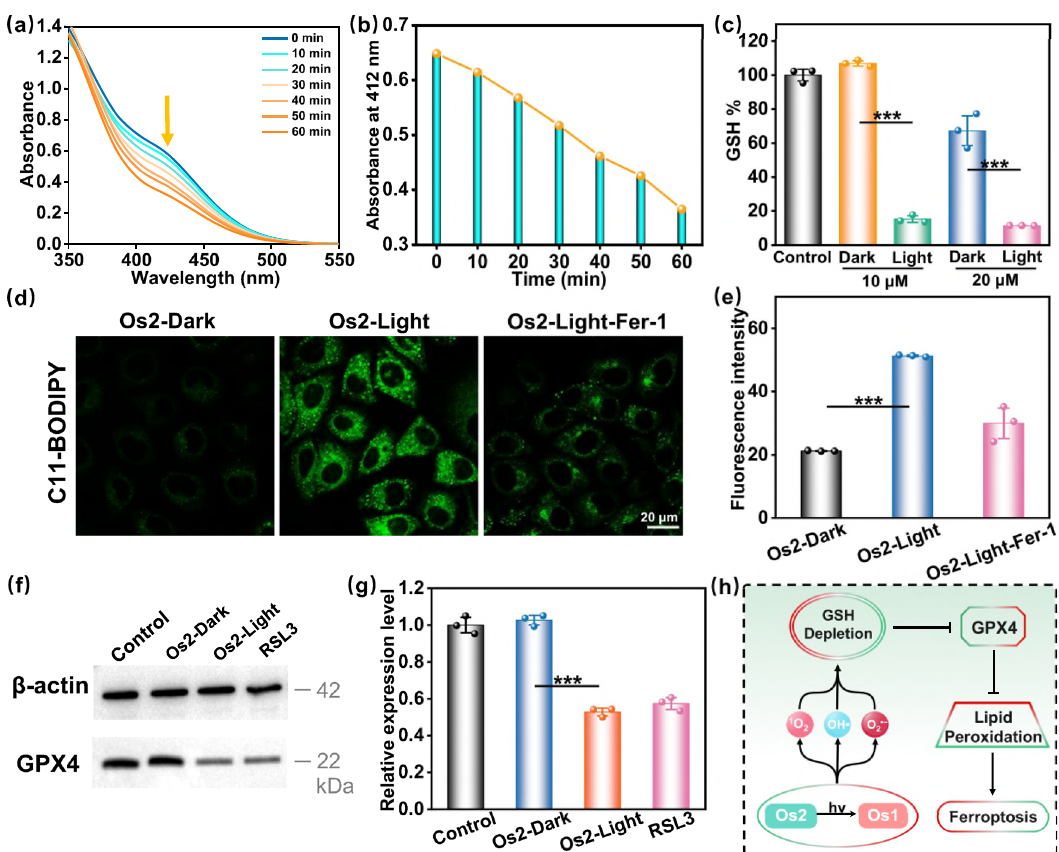
Fig. 5 Ferroptosis induction by Os2 under light irradiation. a Irradiation time-dependent GSH (200 μ M) depletion by Os2 (20 μ M) upon blue light irradiation at 298K and b the absorption at 412 nm was decreased by increasing the irradiation time. c The GSH levels in cells after different treatments. All the experiments were performed as duplicates of triplicates ( n = 3 biologically independent samples, p values ( p ): 10 μ M-0.000025, 20 μ M-0.00065). d The fl uorescence images of lipid peroxides in the treated cells detected by C11-BODIPY probe (30 μ M, 310 K, 0.5 h). C11-BODIPY: λ ex = 488 nm, = 570 ± 50 nm. e The average fl uorescence intensities calculated from the images in d . The experiment was repeated three times independently with λ em similar results, p = 0.000024. f Western blot analysis of GPX4 in HeLa cells after treatment with Os2 (20 μ M, 310 K, 8 h) with or without light treatment. RSL3 is the positive control group. g The relative expression levels of GPX4 calculated from f All the experiments were performed as duplicates of triplicates ( n = 3 biologically independent samples, p = 0.000025). Error bars represent SD from the mean. Statistical signi fi cance was calculated with two-tailed Student ’ s t test (* p < 0.05, ** p ≤ 0.01 or *** p ≤ 0.001). h The process of ferroptosis in this photoactive antitumor therapy. Light